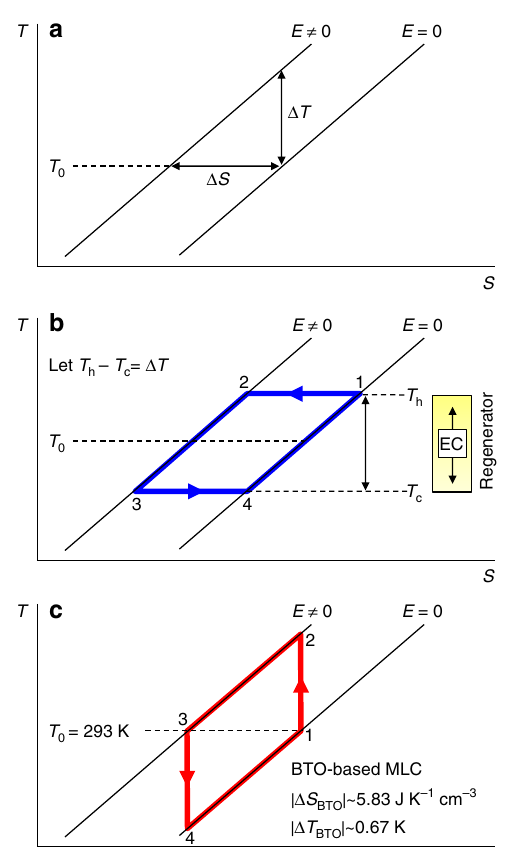
Fig. 1 Simpli fi ed EC materials performance and resulting refrigeration cycles. a Near and at optimum starting temperature T 0 , we assume that one can achieve the maximum adiabatic temperature change Δ T , and the maximum isothermal entropy change Δ S , due to a change of applied electric fi eld E . For the performance schematised in a , we show b an Ericsson cycle (1 → 2 → 3 → 4) where a thermal gradient in a fl uid regenerator permits the separation of T c (at which heat is absorbed) and T h (at which heat is expelled), and c the Brayton cycle (1 → 2 → 3 → 4) that we realize experimentally using two BTO-based MLCs, C1 and C2. Values for | Δ T BTO | and | Δ S BTO | describe the BTO layers